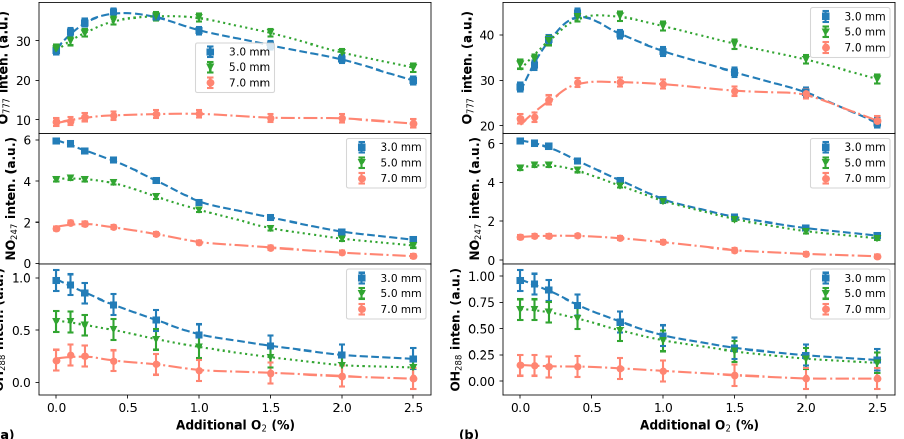
Figure 6. Emission intensities of selected lines/bands from O, NO, and OH radicals as a function of the additional O 2 percentage for different d values (indicated in the curve legends). The data were measured for He flow rates of 1.5 L/min in ( a ) and 2.0 L/min in ( b ). Symbols represent experimental data and lines are trend